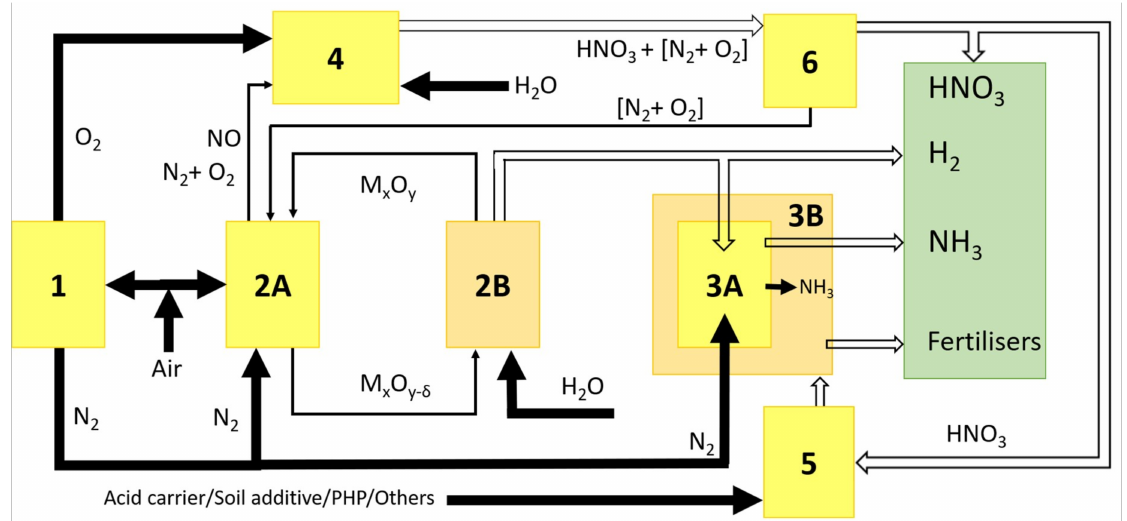
Figure 37. Diagrammatic illustration of nitric acid, hydrogen, ammonia and fertilizer production from air and water through catalytic plasma nitrogen oxidation and catalyst re-oxidation with water for hydrogen production for ammonia and fertilizer synthesis. Individual unit operations are represented by: (1) Air separation; (2) Chemical Looping Reactor with: (2A) NO x generation and catalyst reduction by plasma; (2B) Hydrogen generation and catalyst re-oxidation; (3) Multi-reaction zone plasma reactor [2,3] with: (3A) Plasma reactor (Plasma zone) for NH 3 production, (3B) NH 3 neutralization reactor using acids absorbed on carriers; (4) Nitric oxide oxidation and nitric acid reactor; (5) Acid carrier / Soil additive / PolyHIPE Polymer [2,3] and Acid mixing stage; (6) Nitric acid-NO x